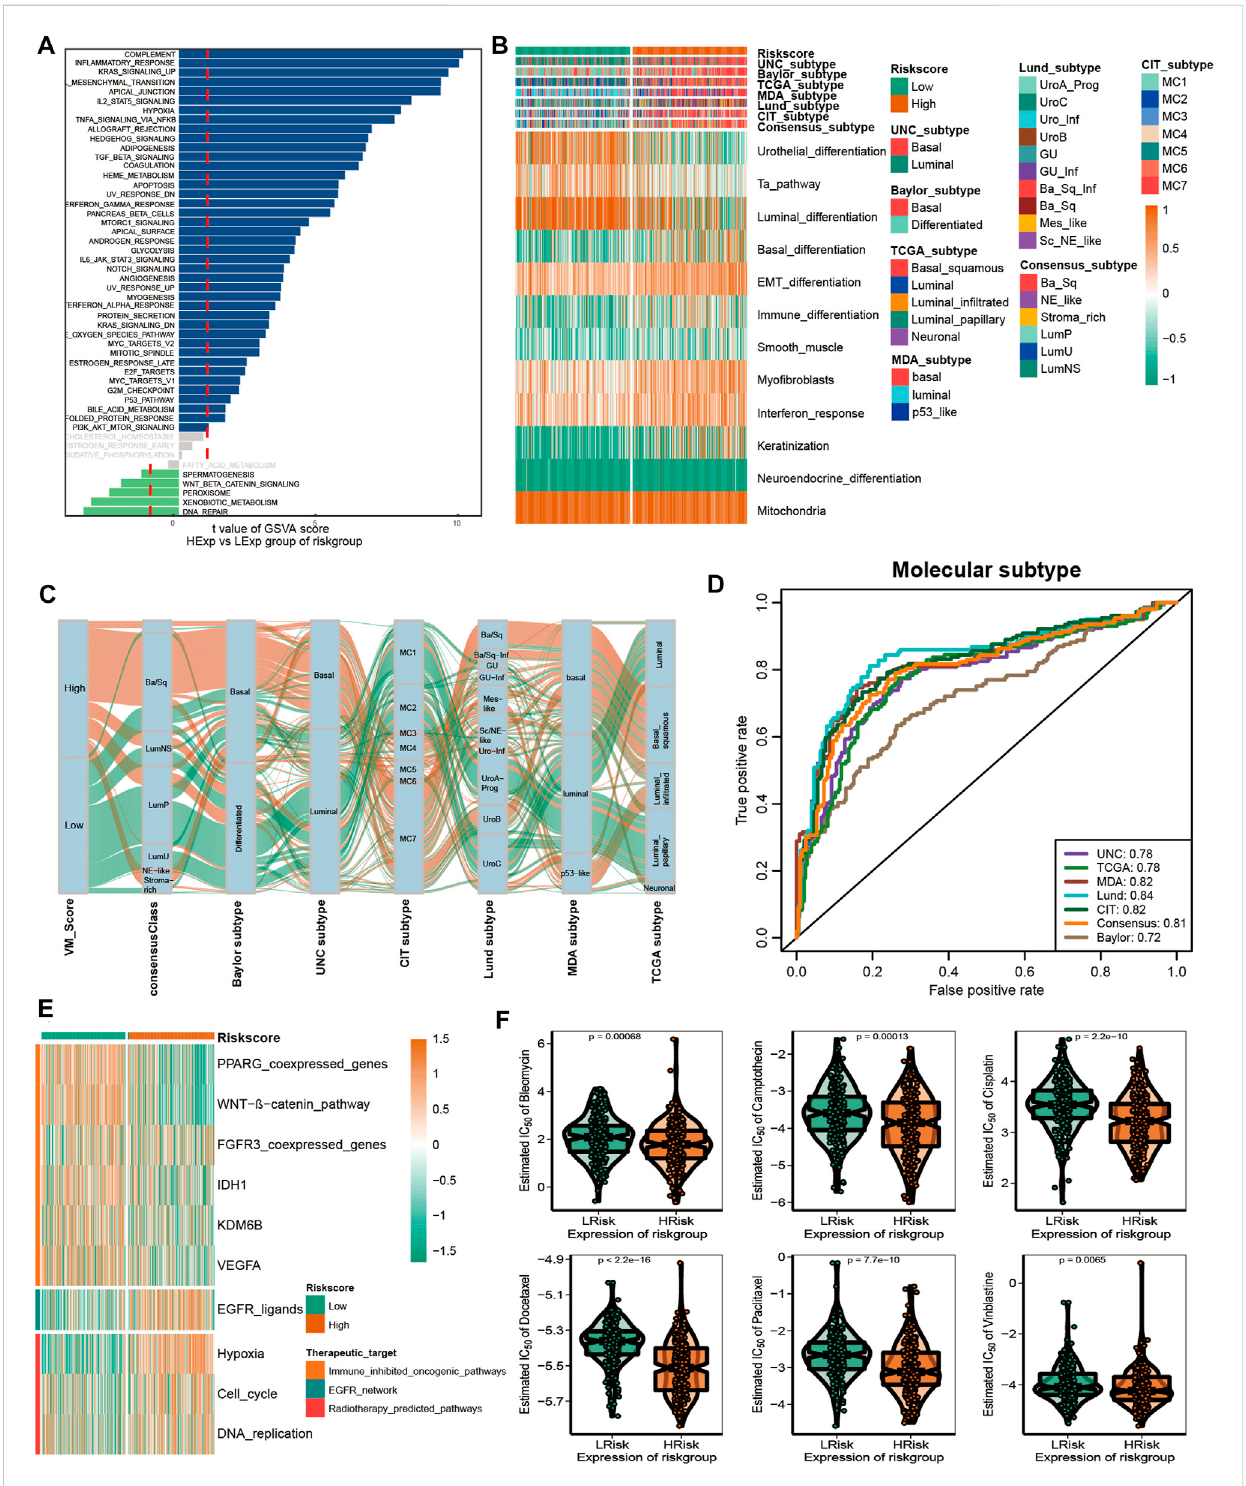
FIGURE 6 VM_Score effectively predicted molecular subtypes and therapy response. (A) Differences in biological function between VM_Score groups. (B,C) Relationship between VM_Score and seven classical molecular subtypes. (D) Predictive accuracy of VM_Score for molecular subtypes in multiple different algorithms. (E) Relationship between VM_Score and enrichment scores of multiple therapeutic signatures. (F) Difference on the effects of six chemotherapy